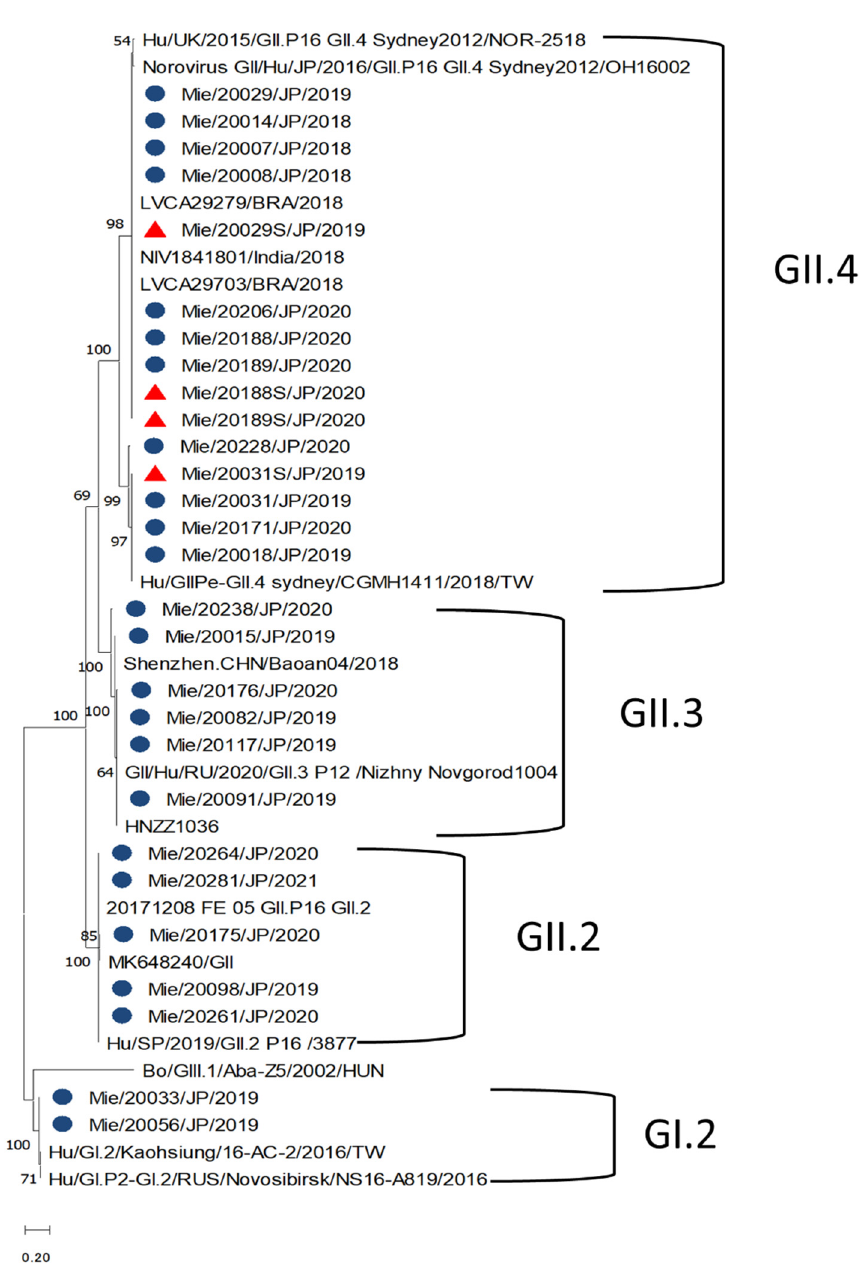
Figure 5. Phylogenetic analyses generated by the maximum likelihood test using the partial nucleotide sequences (338, 302, and 342 bp) from the C region of the capsid of norovirus. The strains reported in this study are indicated with a blue circle (stool) and a red triangle (sera).